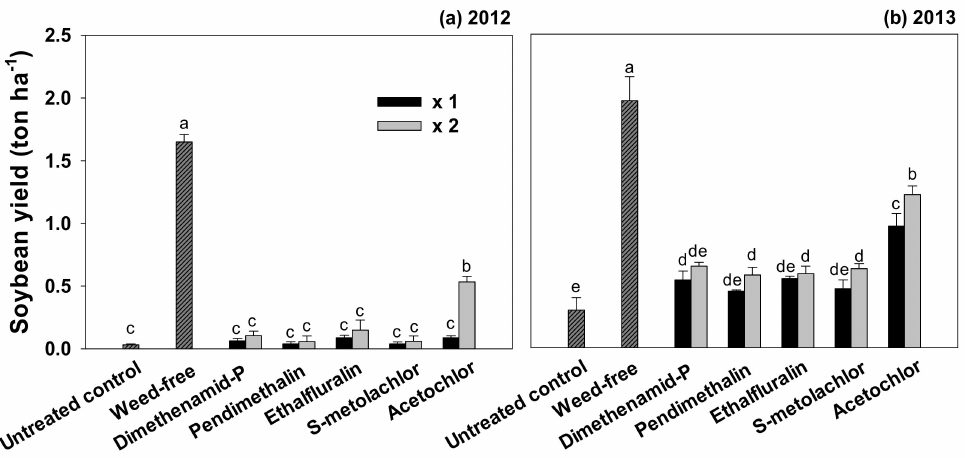
Figure 1. The seed yields (t ha − 1 ) of soybean with a single application of pre-emergence (PRE) herbicides in 2012 ( a ) and 2013 ( b ). The vertical bars represent the SE of the mean of three replicates. Means with the same letter are not significantly di ff erent by Duncan’s multiple range test (DMRT) at p <